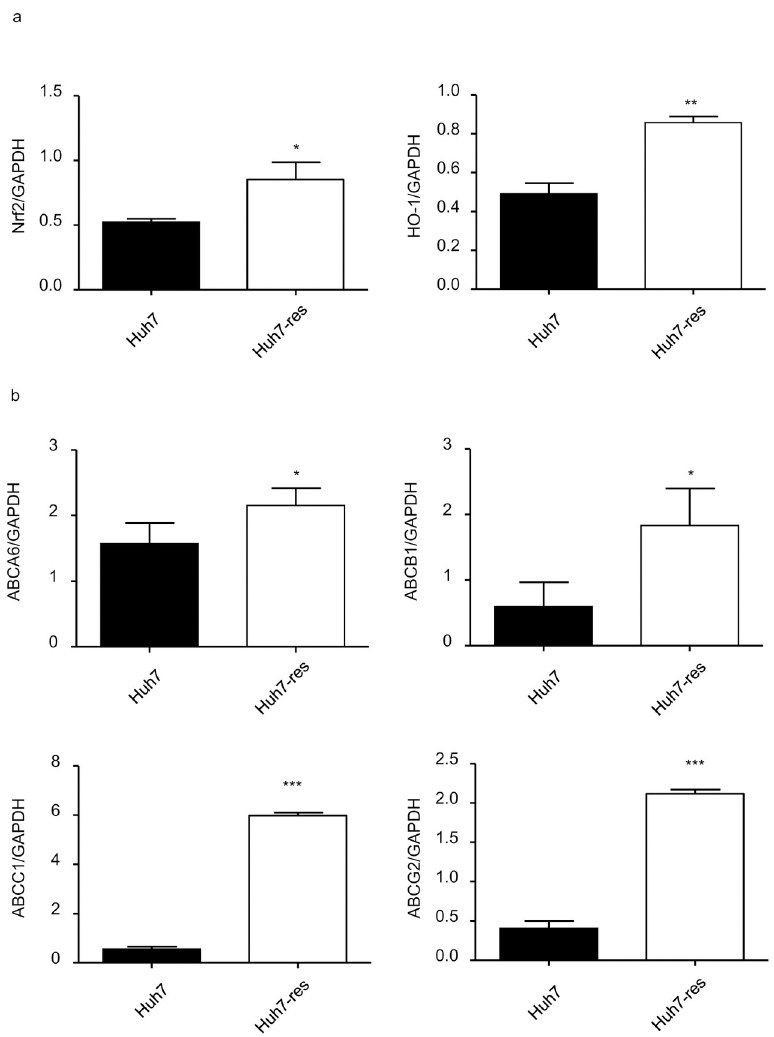
Fig 4. Related mRNA expression of Nrf2 and ABC transporters were upregulated in sorafenib-resistant Huh7 cells. a. PCR quantification of Nrf2 and HO-1 mRNA expressed in sorafenib-resistant Huh7 cells compared with normal Huh7 cells, expressed for 48h cultured in DMEM (10%FBS). (n = 4) � indicates P value < 0.05) �� indicates P value < 0.01) ��� indicates P value < 0.001. b. PCR quantification of ABCA6, ABCB1, ABCC1, ABCG2 mRNA expressed in Sorafenib-resistant Huh7 cells compared with normal Huh7 cells, expressed for 48h cultured in DMEM (10%FBS). (n = 4) � indicates P value < 0.05) �� indicates P value < 0.01) ��� indicates P value < 0.001.